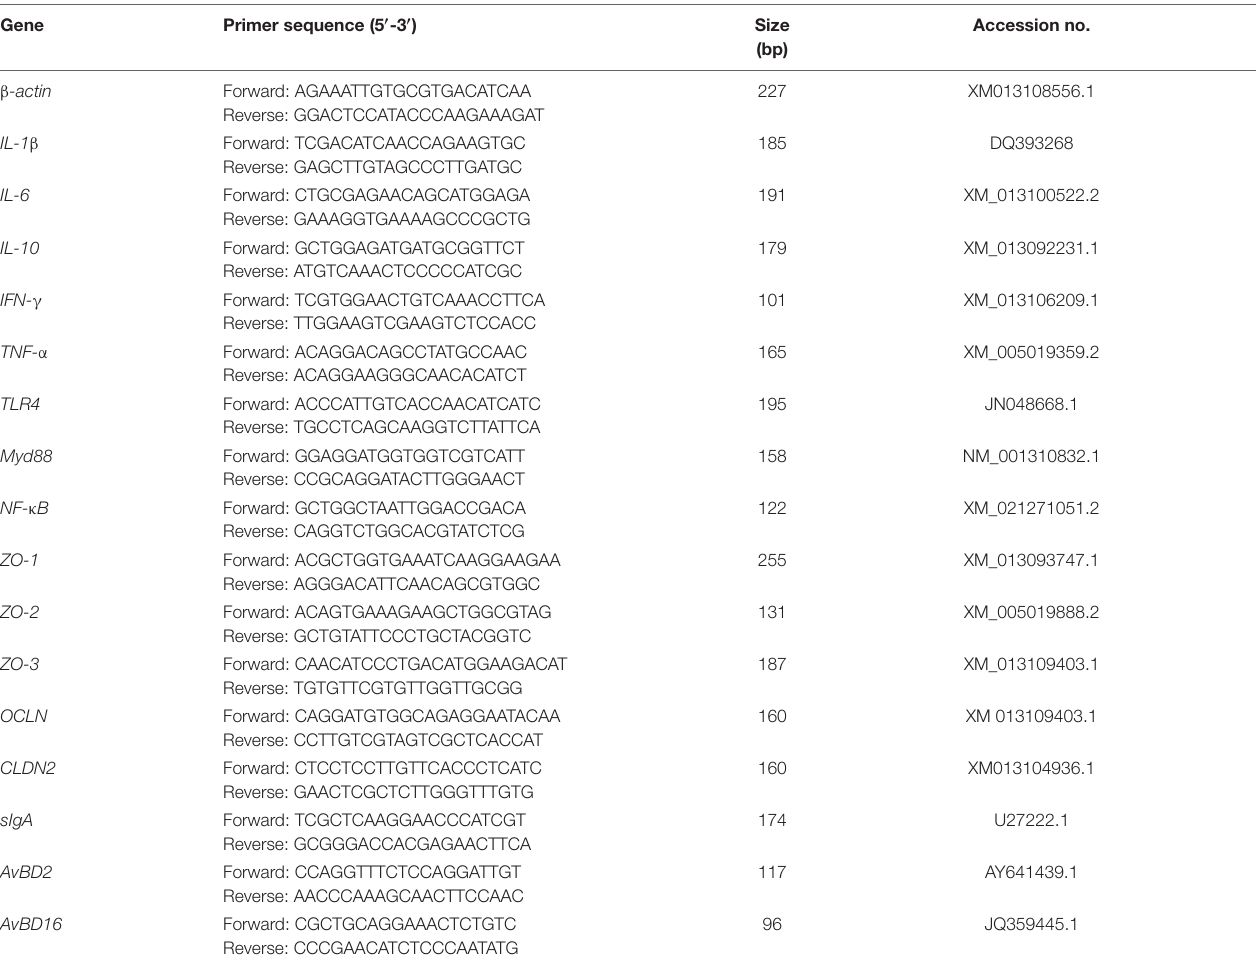
TABLE 2 | Primer sequences for quantitative RT-PCR. Gene Primer sequence (5 (cid:48) -3 (cid:48)